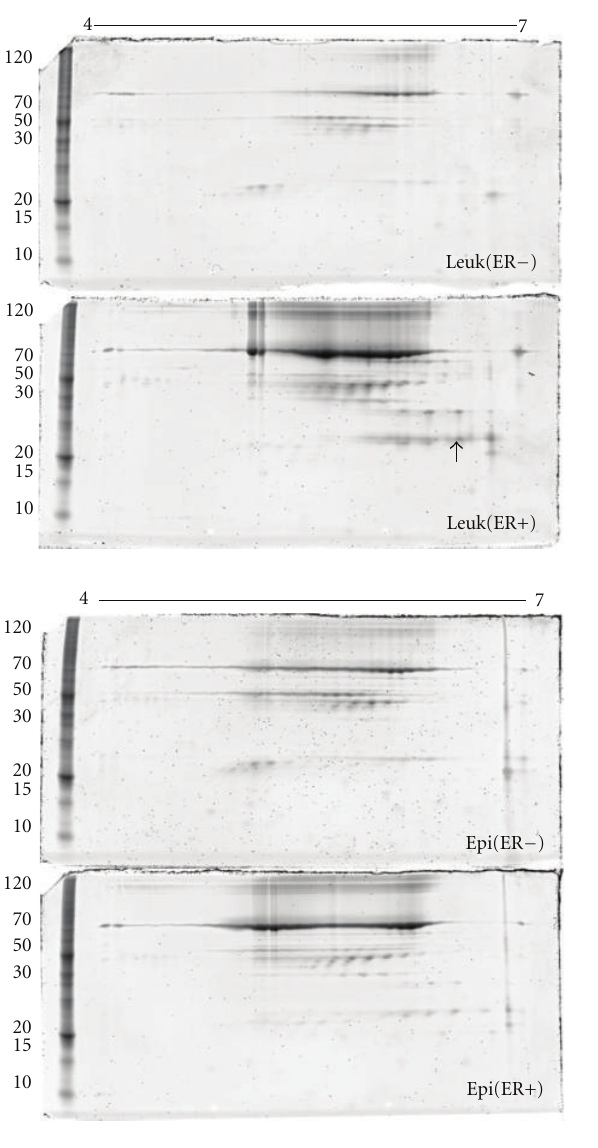
Figure 1: 2DE: two-dimensional gel electrophoresis (2DE) of epithelial cells (Epi), myofibroblasts (Myo), leukocytes (leuk), and endothelial cells (Endo) proteins separated from estrogen receptor-positive and estrogen receptor-negative breast cancer cells using antibody-bound magnetic beads. First dimension was performed on a pH 4 to 7 isoelectric focusing gels and the second dimension was done utilizing 10% polyacrylamide gels. Gels were stained by Sypro Ruby. Arrows point to identified proteins